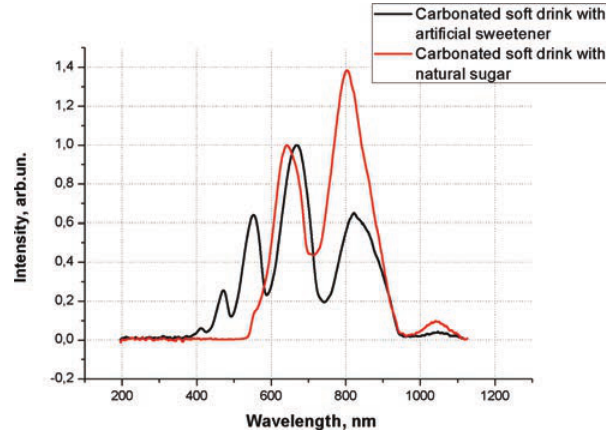
Fig. 6. Normalized transmission spectra of the PCW samples, ¯lled up with carbonated soft drink with arti¯cial sweetener and natural sugar.